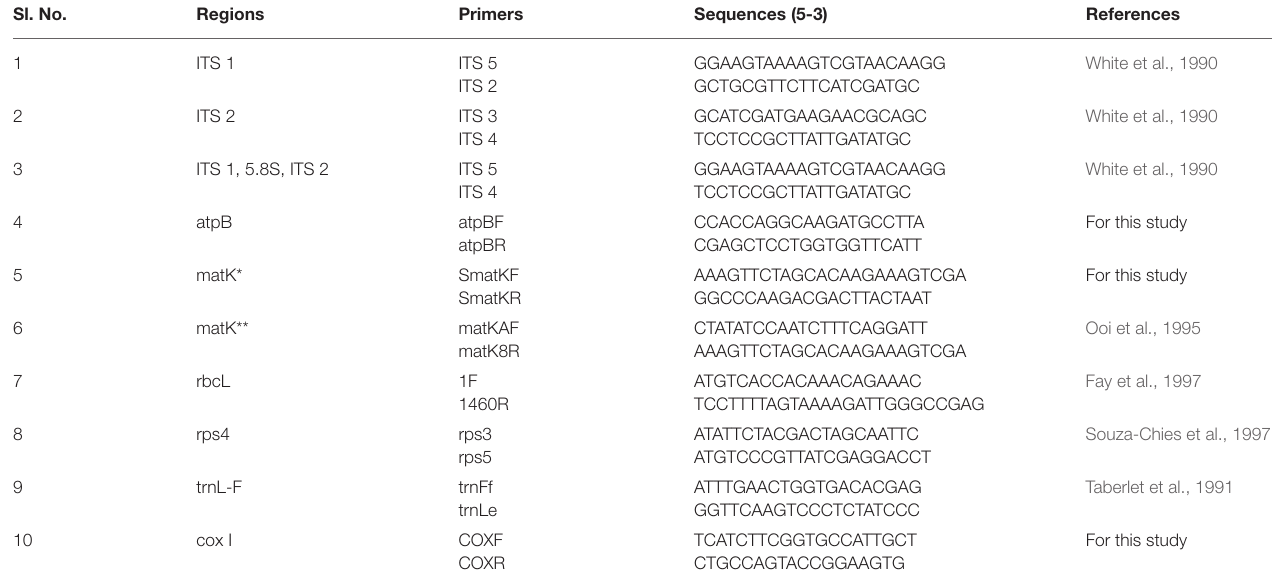
TABLE 4 | Primer details used in this